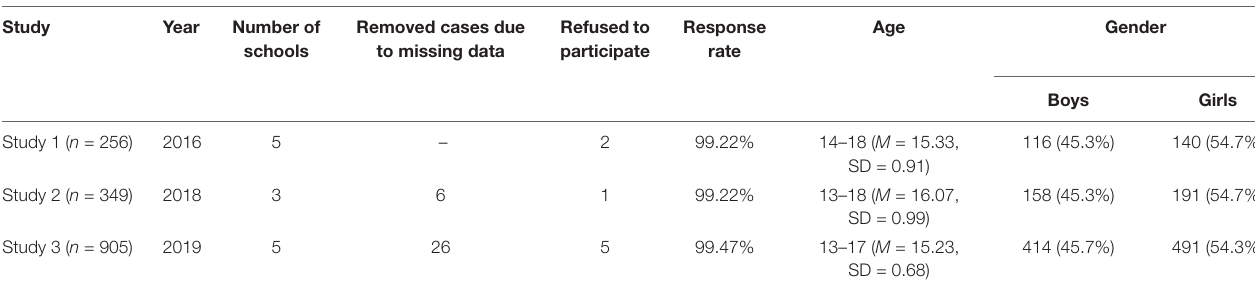
FIGURE 2 | Geographical representation of regions where three studies were conducted. TABLE 1 | Summary of sample